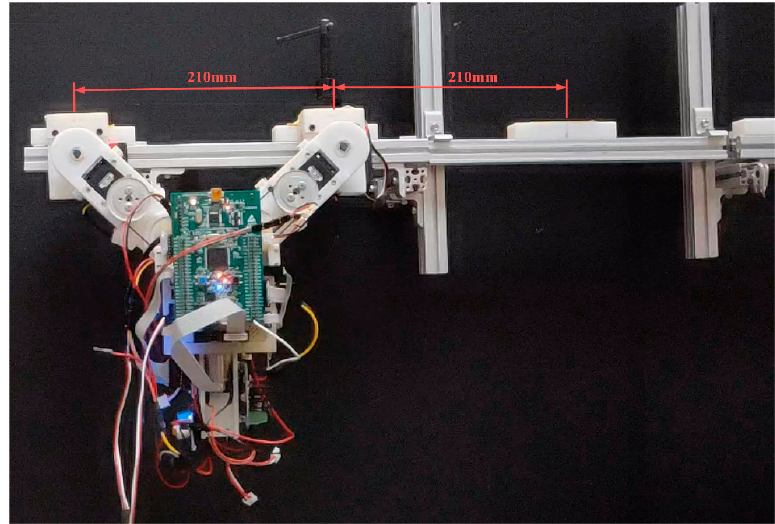
Figure 15. Setup used in the first set of experiments. Table 4. Experimental results obtained in the first set of experiments.